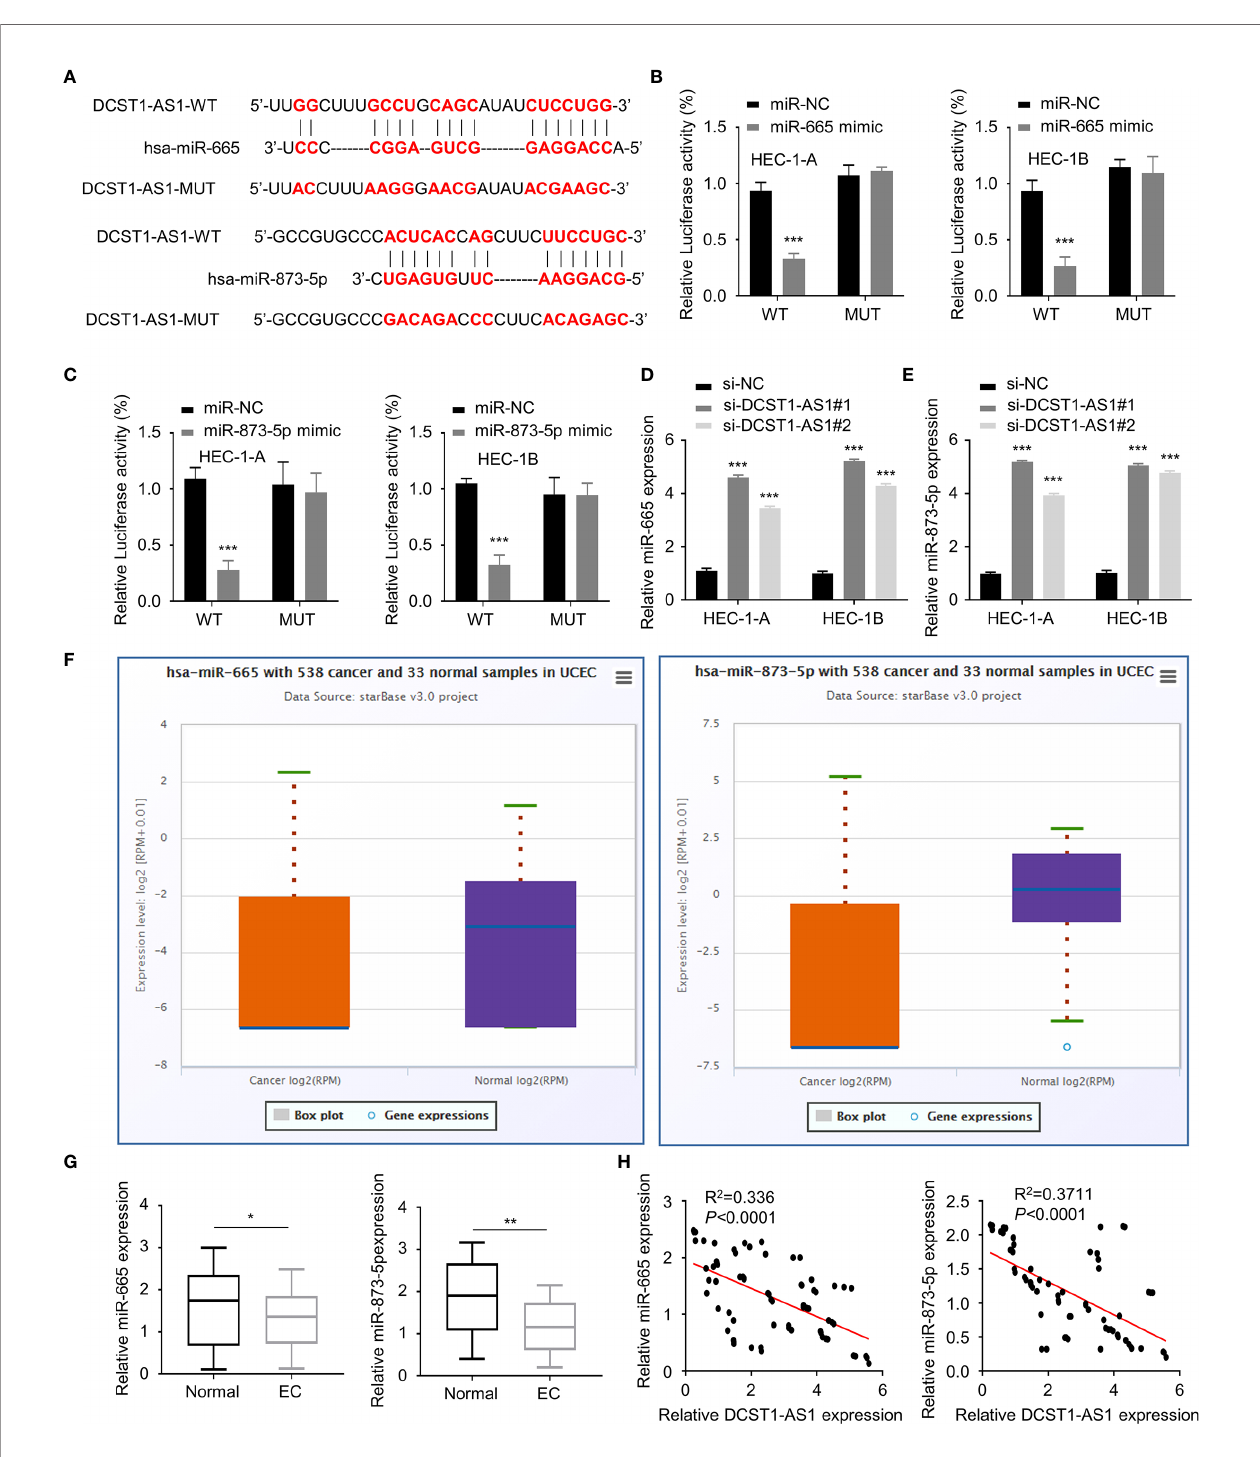
FIGURE 3 | LncRNA DCST1-AS1 acts as a sponge for microRNA-665 (miR-665) and microRNA-873-5p (miR-873-5p). (A) Predicted and mutant (lower panel) sequence alignments of miR-665 and miR-873-5p with DCST1-AS1. (B) Wild-type (WT) DCST1-AS1 and mutant (MUT) DCST1-AS1 luciferase reporters were co- transfected with miR-665 mimic or control mimic (miR-NC). Luciferase activity was detected using luciferase assays. (C) Luciferase reporter assays showed that miR-873-5p signi fi cantly reduced luciferase activity of WT DCST1-AS1, but mutation of the miR-873-5p binding site abrogated the inhibitory effects of miR-873-5p. (D, E) The levels of miR-665 (D) and miR-873-5p (E) were tested by RT-qPCR in EC cells with (or without) DCST1-AS1 depletion. (F) The expression of miR-665 and miR-873-5p in EC ( n = 538) and tumor-adjacent normal tissues ( n = 33) (ENCORI database). (G) The levels of miR-665 and miR-873-5p in EC tissues and the adjacent normal tissues were measured using qRT-PCR assay. (H) The correlation of DCST1-AS1 and miR-665/miR-873-5p expression was analyzed by Spearman ’ s correlation analysis. * P < 0.05, ** P < 0.01, *** P <